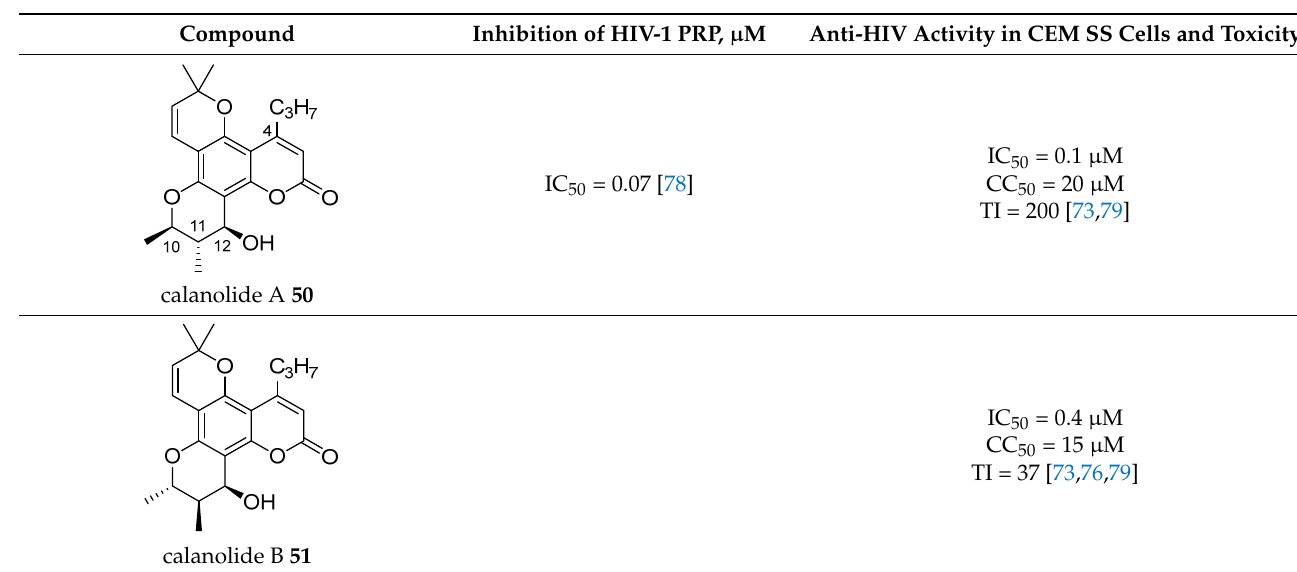
Table 4. Compounds 50 – 60 with anti-HIV-1 activity.